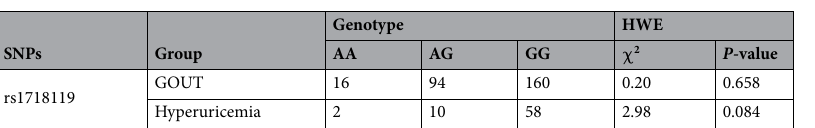
Table 3. Hardy–Weinberg equilibrium test of the genotype frequency distribution in the two groups.